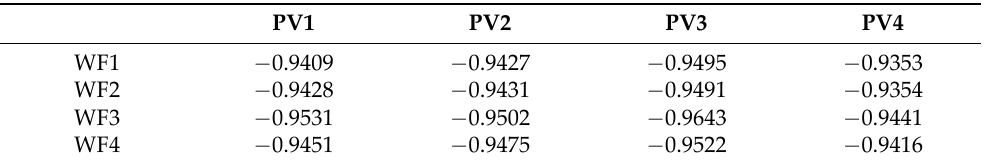
Figure 5. Scenario set of forecasted outputs of wind and photovoltaic power. The Cartesian product was used to combine typical scenarios of the outputs of forecasts of wind and photovoltaic power to obtain 16 combinations of scenarios [7]. The Spearman correlation coefficient was used to analyze the complementarity among the four typical scenarios of each group. The correlation coefficient of the outputs of wind and photovoltaic power under different scenarios were shown in Table 3. Table 3. The correlation coefficient of the outputs of wind and photovoltaic power under different scenarios.